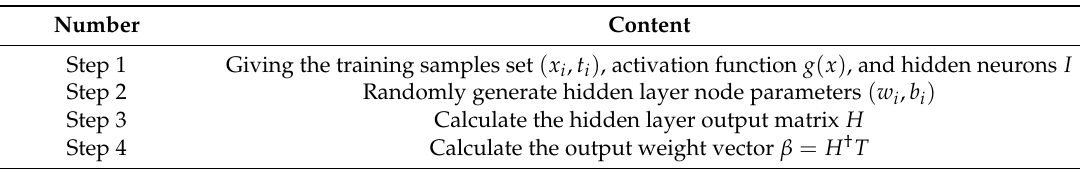
Table 2. Extreme learning machine